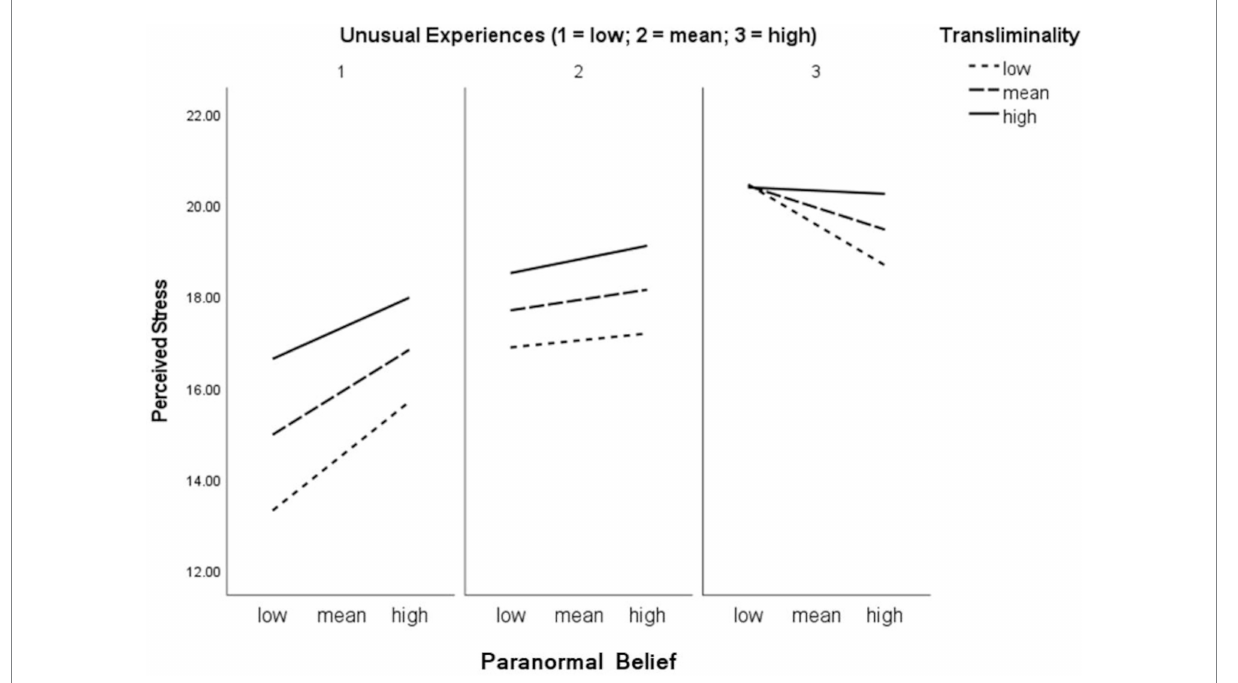
FIGURE 1 Paranormal Belief × Transliminality × Unusual Experiences predict Perceived